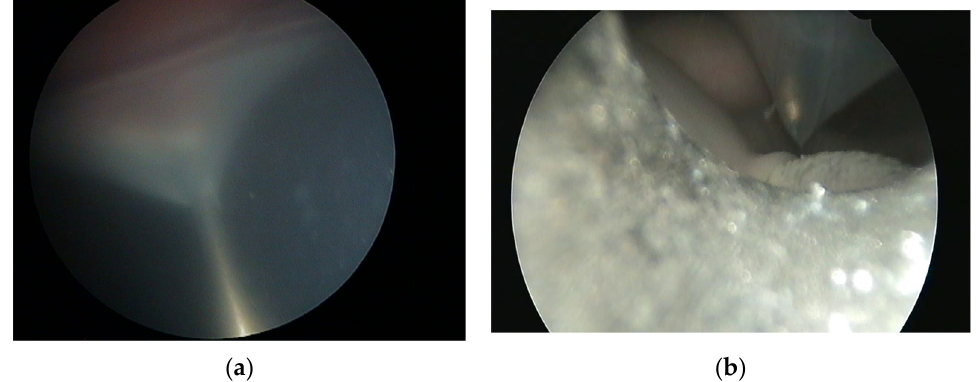
Figure 2. Fetoscopic view of the detachment of uterine membranes in a sheep model during insertion of a 16 G needle for port placement ( a ) and insertion of a 3 mm port ( b ). Below the trocar the umbilical cord can be seen.